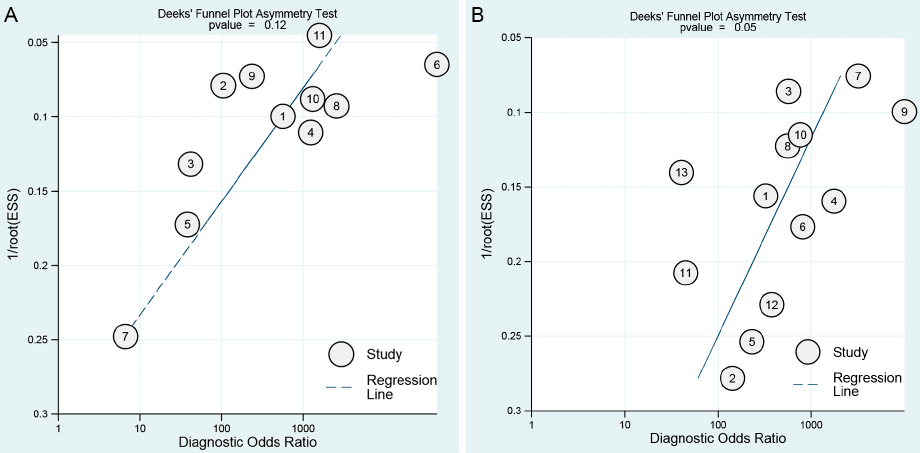
Figure 5. Deeks’ funnel plot asymmetry test for publication bias in different tests for PEDV. ( A ) ICA- based POCTs; ( B ) NAIA-based POCTs. ESS = effective sample size.